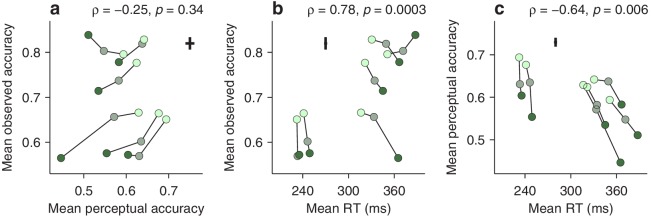
Dissociation between perceptual capacity and overall task performance.In each panel, the data from each participant (joined by lines) are shown for trials of high, medium, and low luminance cues (bright, grayish, and dark green points, respectively). Crosses indicate the typical (median) uncertainty (2 SEs) associated with the measurement in each direction. Partial Spearman correlations between values on the x and y axes are indicated, along with significance (Materials and methods). The partial correlation eliminates the association due exclusively to luminance. (a) Mean observed accuracy versus mean perceptual accuracy. (b) Mean observed accuracy versus mean RT. Average RT data include both correct and incorrect trials. (c) Mean perceptual accuracy versus mean RT.